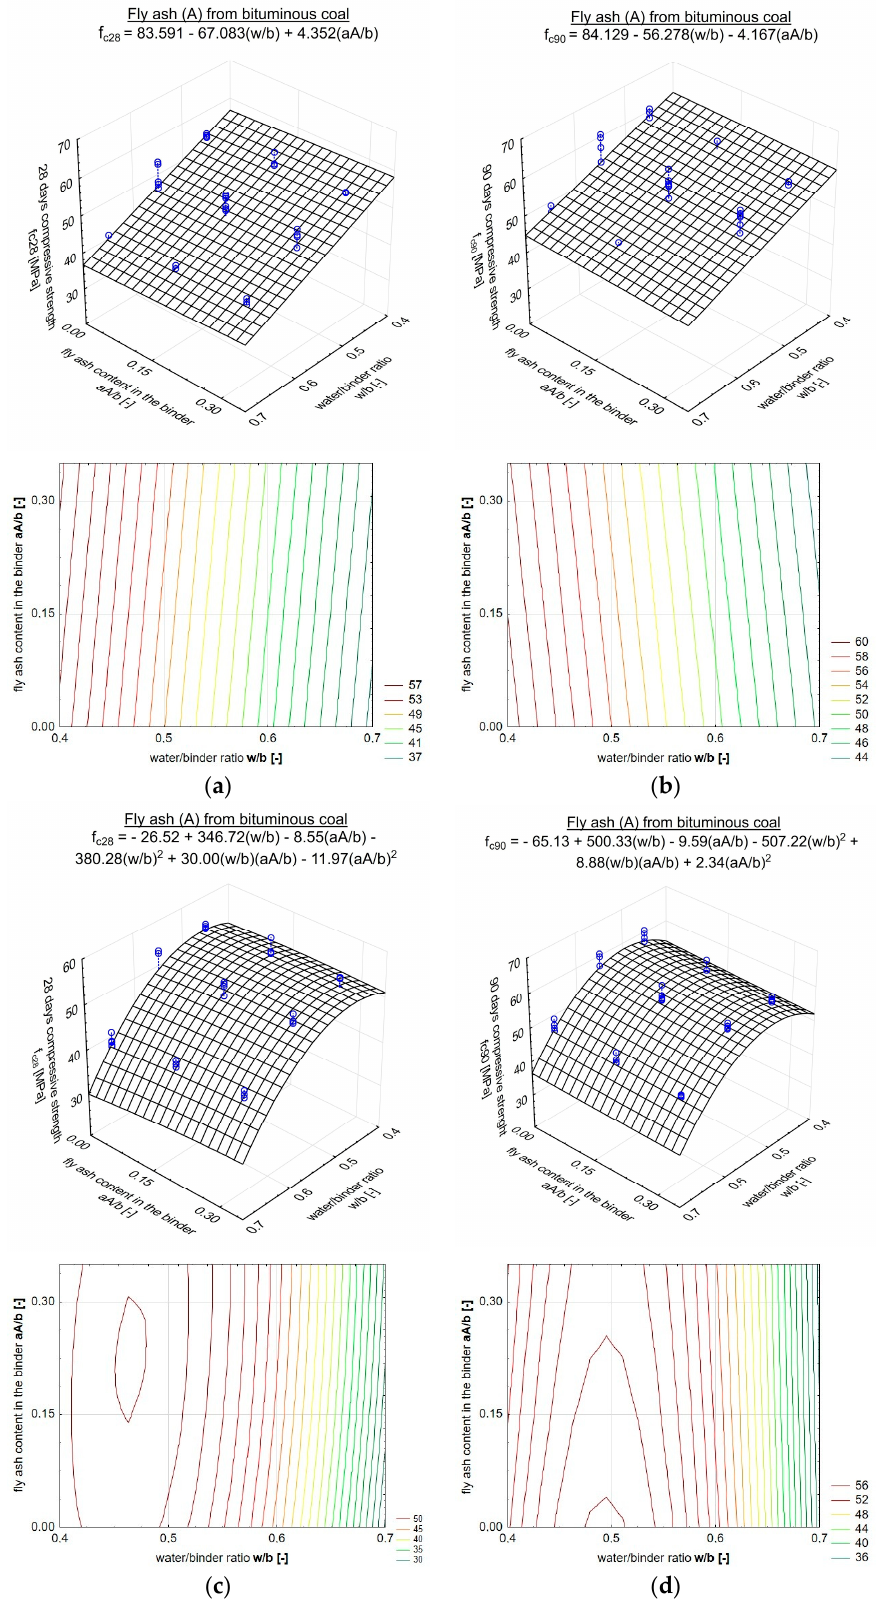
Figure 1. Compressive strength of concretes with fly ash addition A (bituminous coal) after 28 ( a , c ) and 90 ( b , d ) days; test results approximated using a linear function ( a , b ) and a second-degree polynomial ( c , d